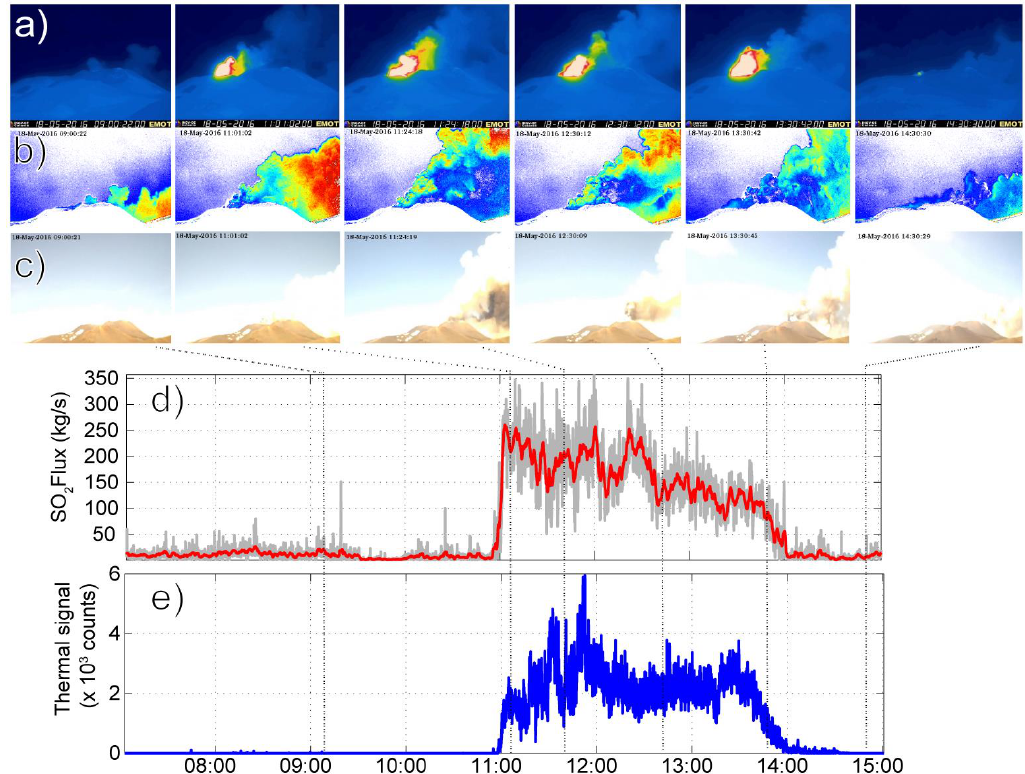
Figure 9. SO 2 camera record during the 18 May lava fountain compared with the thermal signal recorded by the co-located INGV-OE TIR camera. The upper panels show thermal ( a ), absorbance ( b ), and visible ( c ) images of the summit area in specific time intervals. SO 2 fluxes are shown in ( d ) as raw measurements (gray line) with the associated 10 second-window moving average (red line), while the thermal signal is shown in ( e